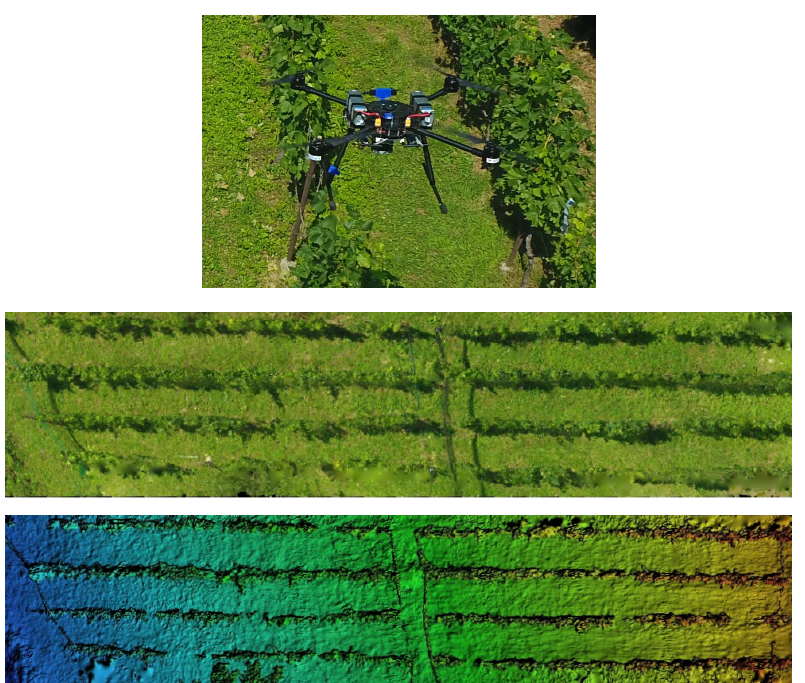
Figure 2. Monitoring the vineyard from the air, top —LAAR monitoring the vineyard, middle — stitched RGB image, bottom —generated 3D